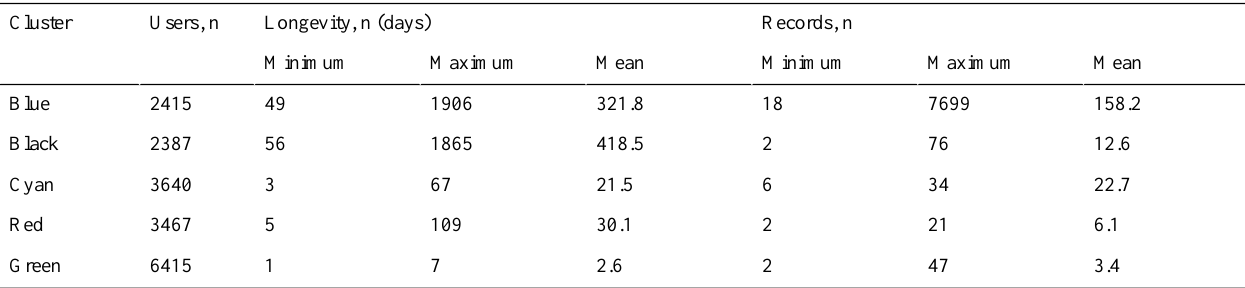
Table 1. Cluster characteristics according to the 5-cluster